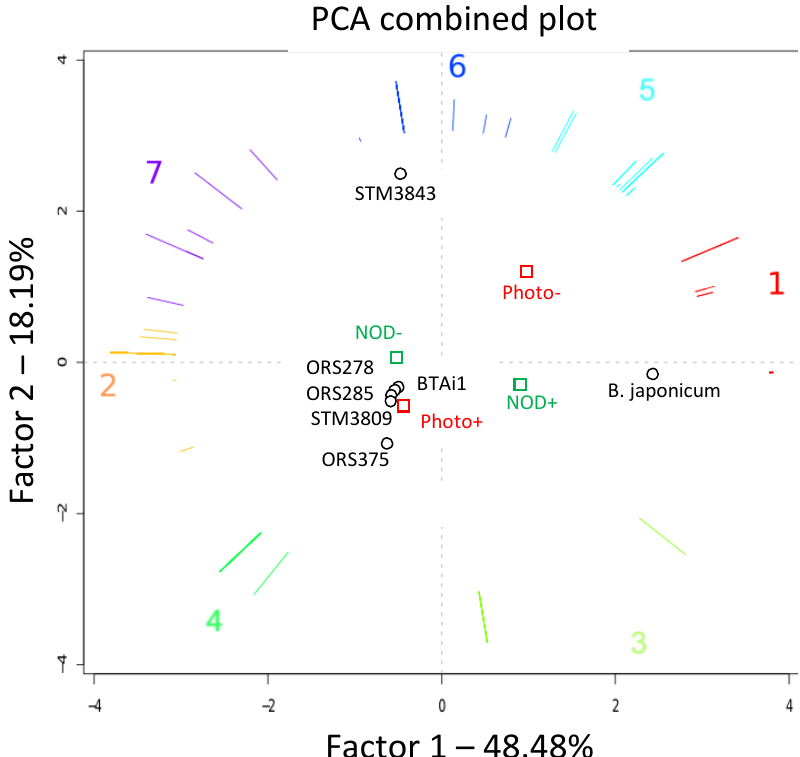
Figure 5. Principal Component Analysis (PCA) of seven Bradyrhizobium genomes, performed on a two dimensional matrix compiling metabolic pathway completion values (the number of enzymatic reactions with coding genes for pathway x in a given organism, divided by the total number of reactions in pathway x as defined in the MetaCyc database; see Experimental Section) across all genomes. In the plot, each genome is represented by a point, whereas pathways are shown as colored vectors. Pathways with correlated completion values across organisms (vectors with similar orientation) have been clustered (corresponding to numbers 1 to 7) and drawn in the same color (vectors of pathways with identical completions overlap). Genomes can be associated with their representative and characteristic groups of metabolic pathways ( i.e ., vectors “pointing in their direction”). The corresponding pathway functions are listed in Supplementary Table S2. Vector length encodes the quality of representation of the pathway in the presented plot ( i.e ., the longer a vector is, the more representative its pathway is for genomes on the same side of the plot). Abbreviations: photo − /photo+: non-photosynthetic/photosynthetic strains; Nod+/Nod − : nod-dependent/nod-independent strains).